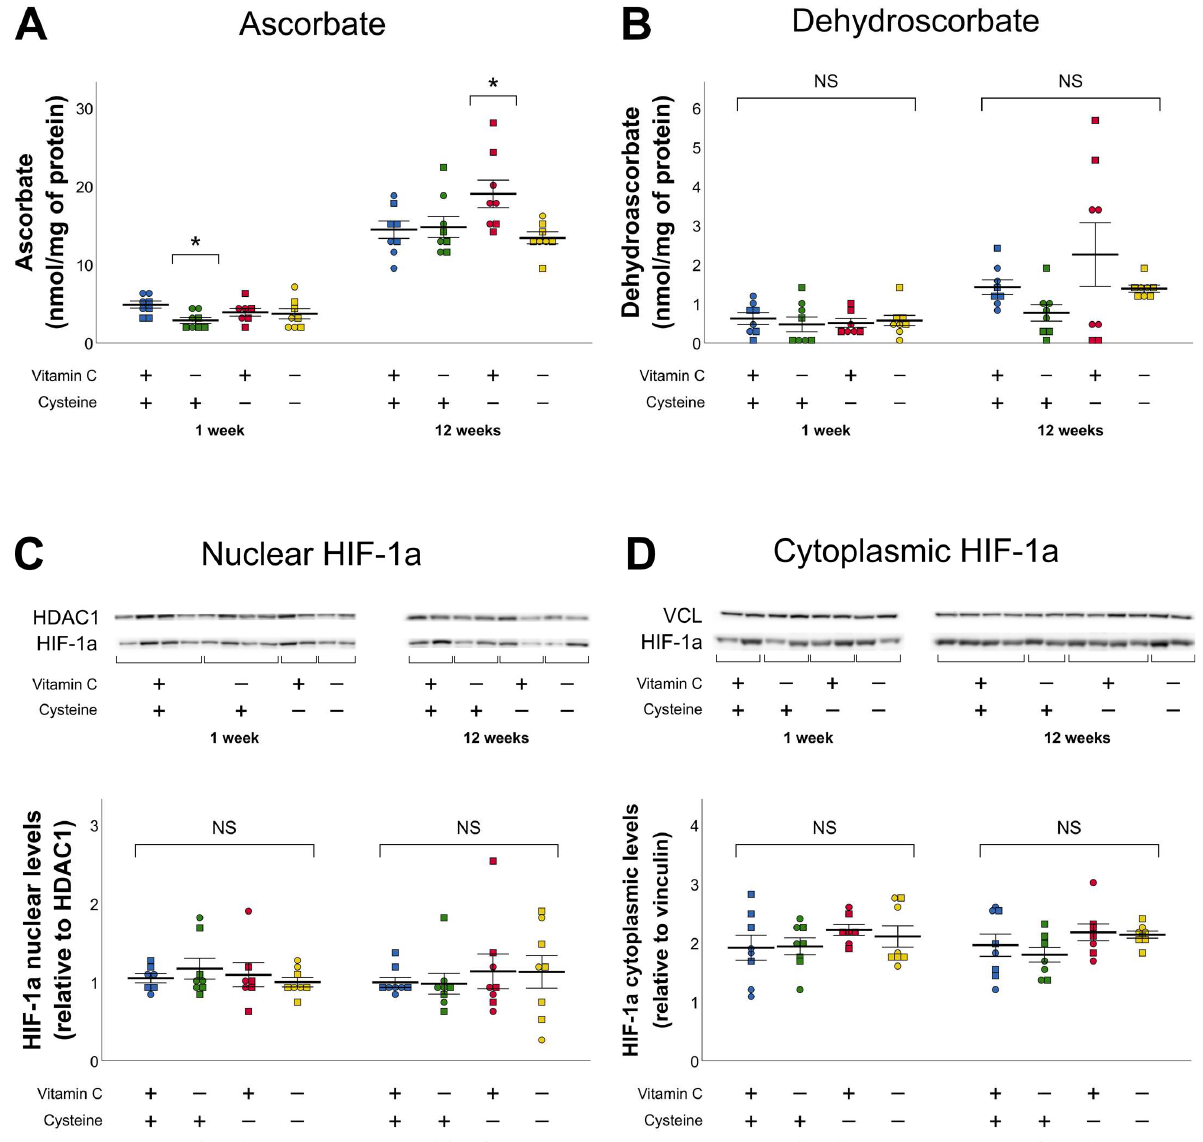
Figure 2. Hepatic levels of ascorbate, dehydroascorbate, and HIF-1 α in nucleus and cytoplasm in 1-week- and 12-week-old animals. ( A ). Ascorbate levels were decreased at 1 week of life by vitamin C deficiency, and were increased at 12 weeks of life in the cysteine deficiency group, with a significant interaction between both deficiencies ( p < 0.05). ( B – D ): No statistically significant differences were observed in dehydroascorbate or HIF-1 α levels in nucleus or cytoplasm either at 1 week of life or at 12 weeks. Mean ± SEM. Circles: male animals; squares: female animals; NS: statistically non-significant; *: p <